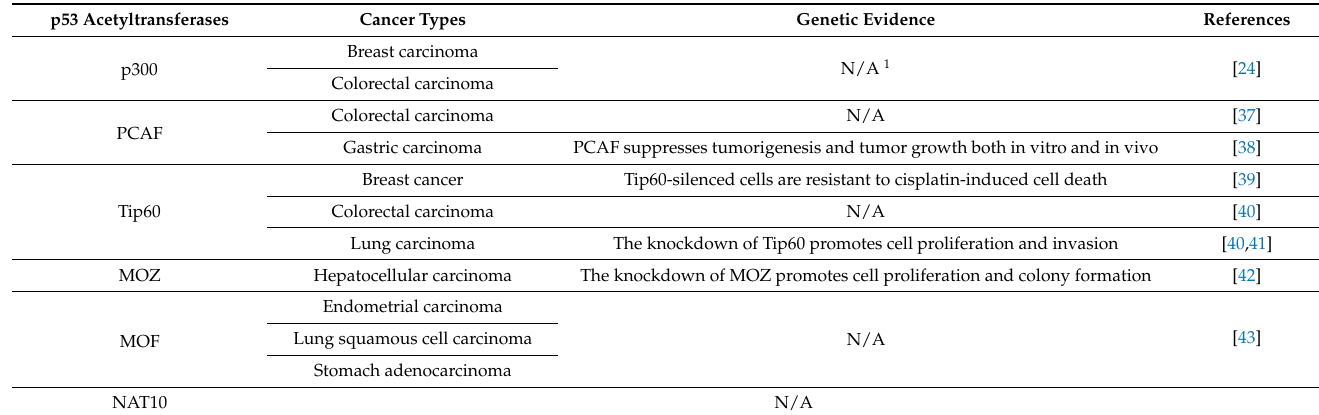
Table 1. List of cancer types with low-expressed p53